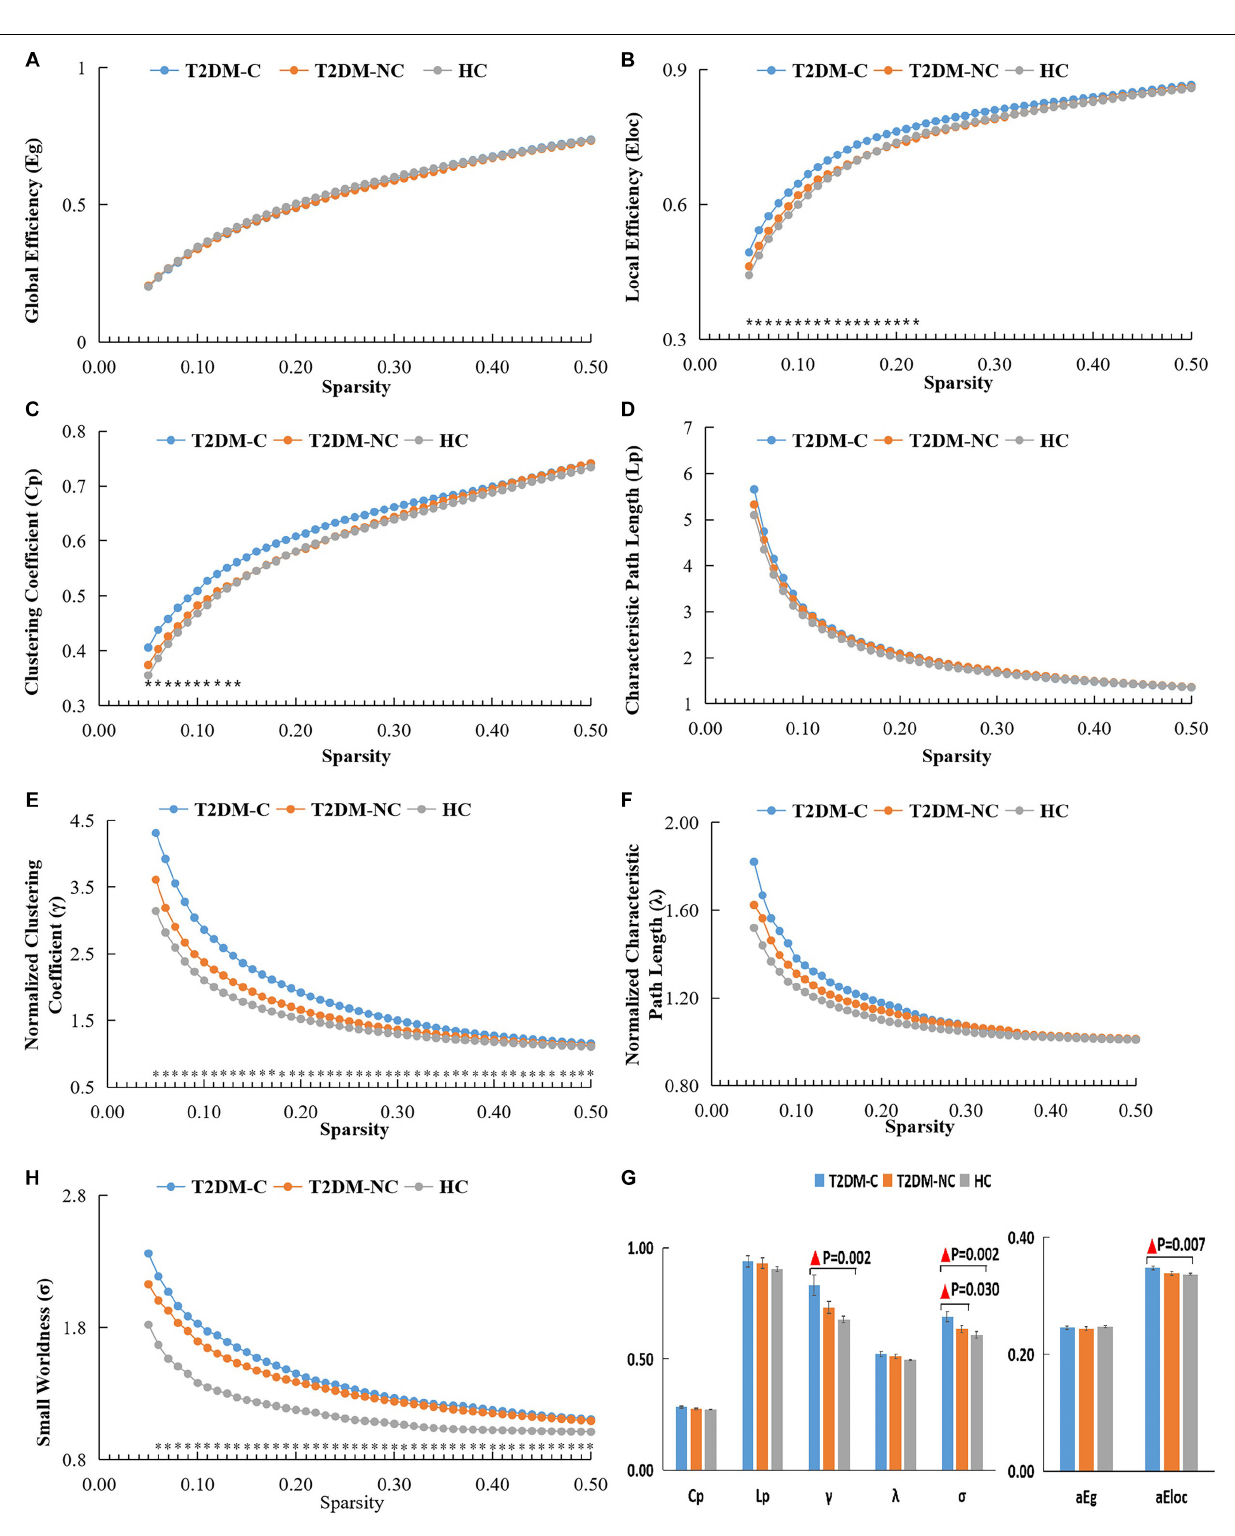
Frontiers in Neuroscience |